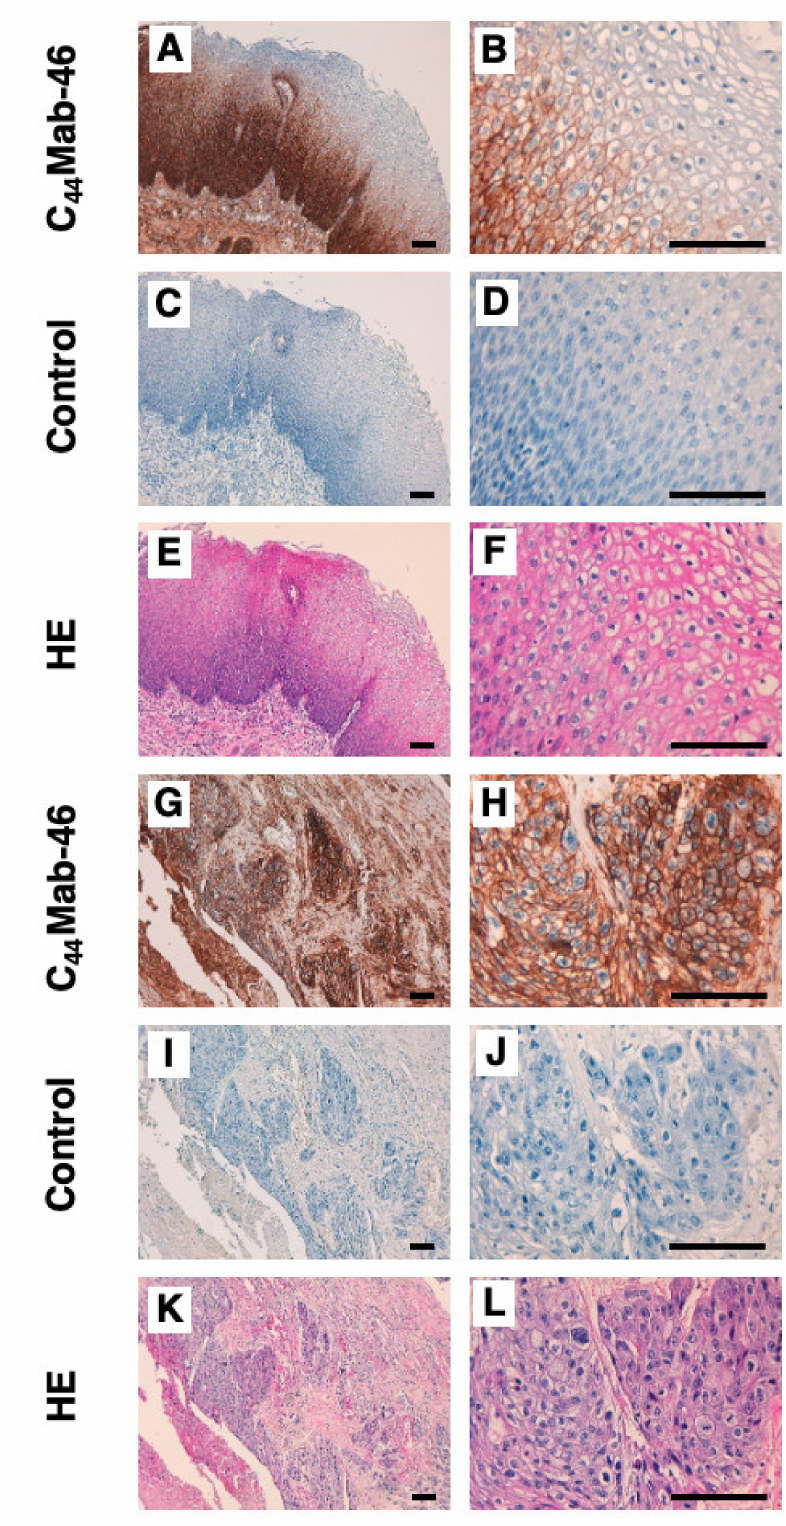
Figure 5. Immunohistochemical analysis using C 44 Mab − 46 against ESCC tissues. ( A – D , G – J ) After antigen retrieval, sections were incubated with 5 µ g/mL of C 44 Mab − 46 or negative control (blocking buffer) followed by treatment with the Envision+ kit. Color was developed using DAB, and sections were counterstained with hematoxylin. ( E , F , K , L ) Hematoxylin and eosin (HE) staining. Scale bar = 100 µ